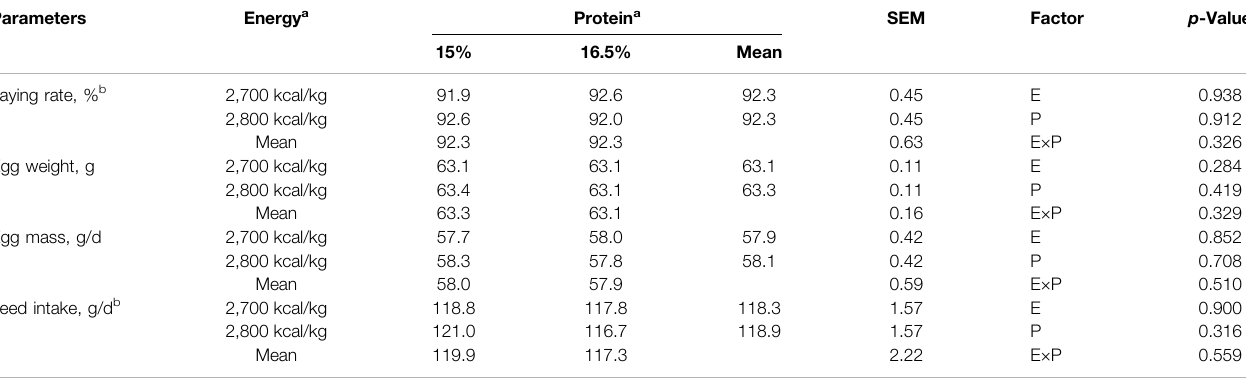
TABLE 3 | Effect of dietary metabolizable energy (E) and crude protein (P) levels during the prelay period (15 – 20 weeks of age) on production performance in laying hens at 72 weeks. Parameters